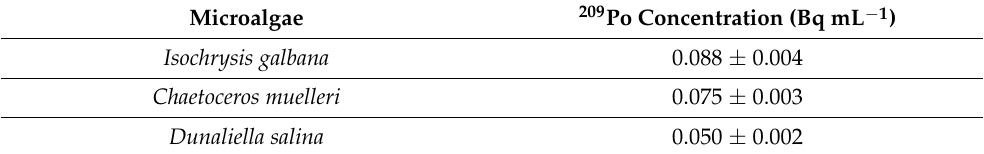
Table 1. Average 209 Po concentration in water with